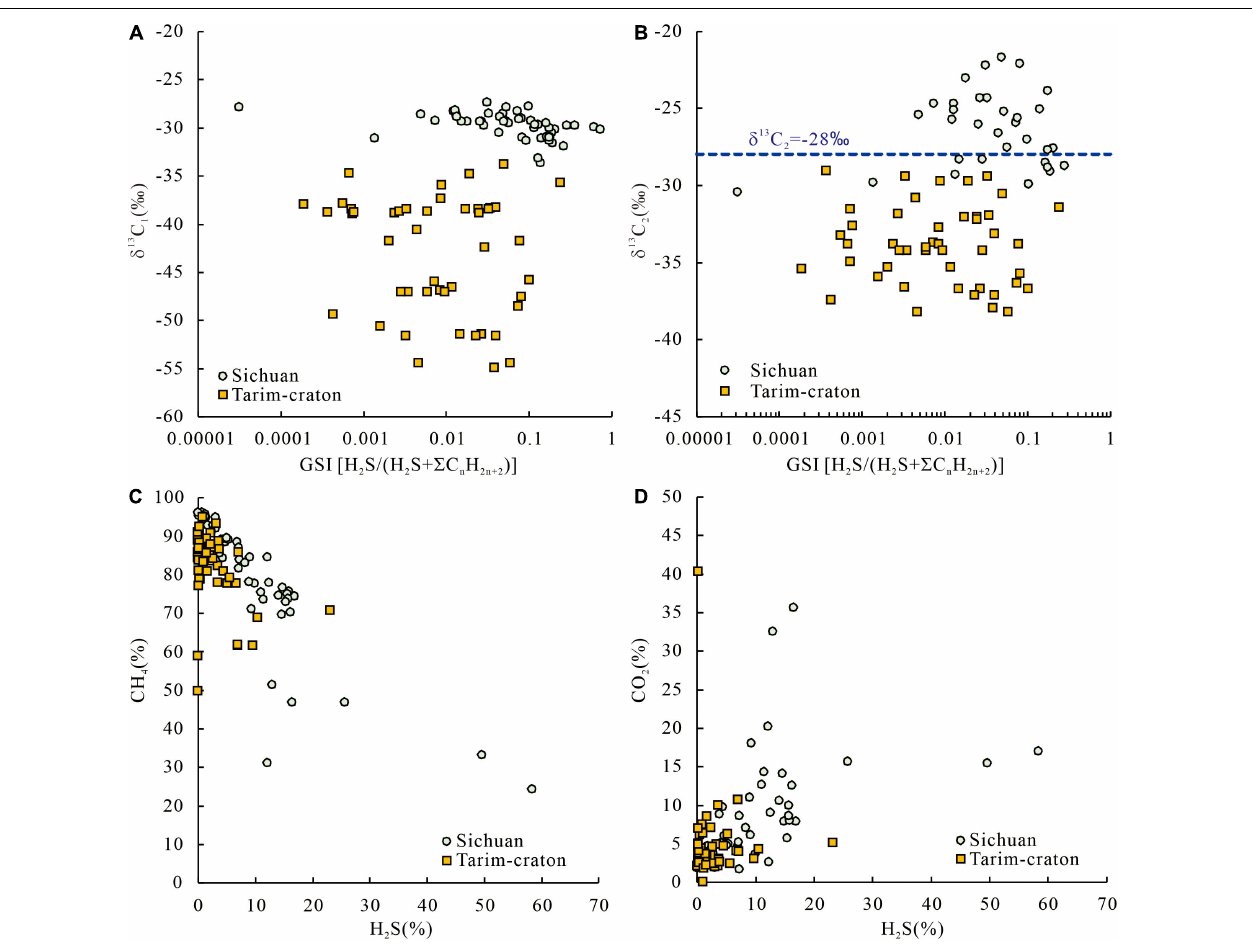
FIGURE 9 | Plot of δ 13 C 1 vs. GSI [H 2 S/(H 2 S + Σ C n H 2n + 2 )] (A) , δ 13 C 2 vs. GSI [H 2 S/(H 2 S + Σ C n H 2n + 2 )] (B) , CH 4 vs. H 2 S (C) , and CO 2 vs. H 2 S (D) of gases from the craton area of Tarim Basin and Sichuan Basin. Data source see section “Samples and Methods” in the text.